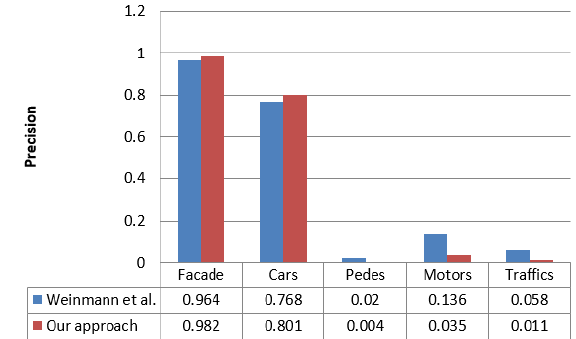
Figure 4. Precision values in the five